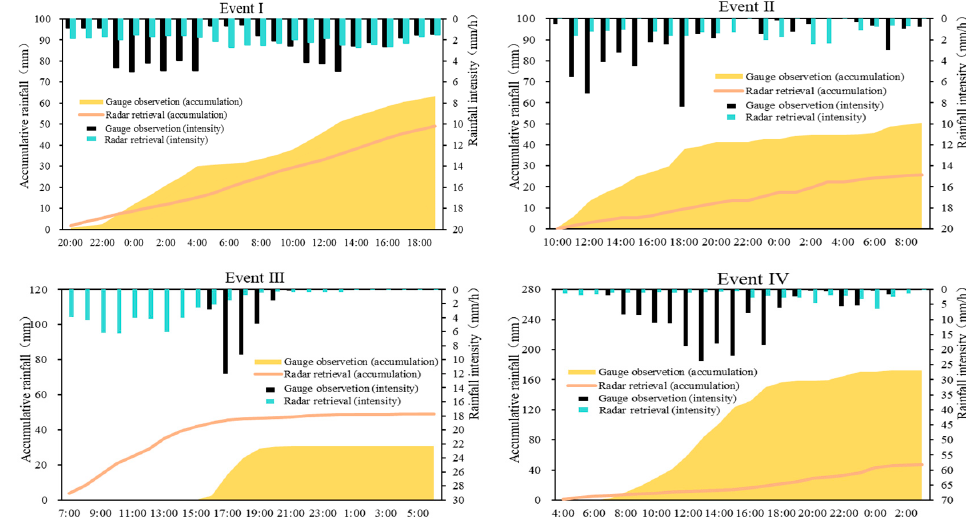
Figure 5. Observations and radar measurements of 24 h rainfall accumulations for Event Ⅰ , Ⅱ , Ⅲ , Ⅳ .